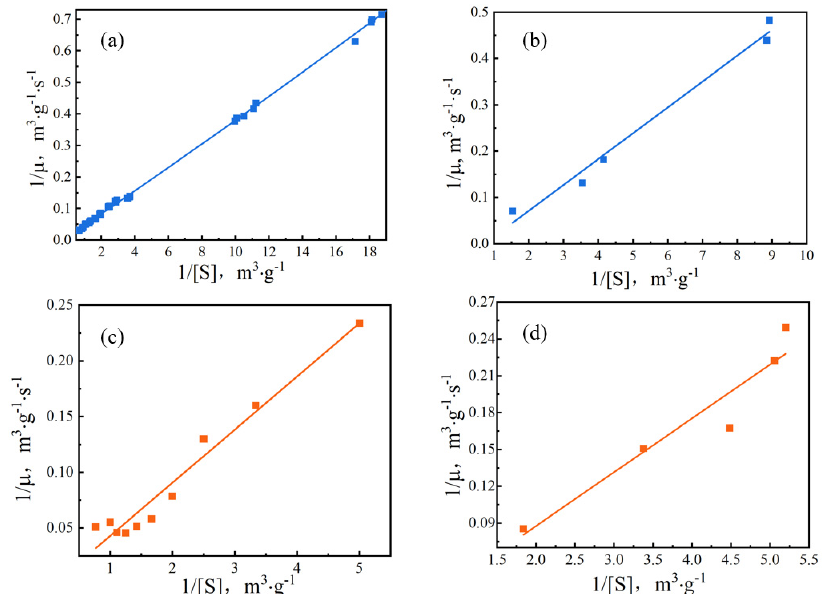
Figure 7. Kinetics of the biodegradation process. ( a ) Biodegradation of chlorobenzene; ( b ) biodegradation of chlorobenzene with mixed components substrate of chlorobenzene and xylene; ( c ) biodegradation of xylene; ( d ) biodegradation of xylene with mixed-component substrate of chlorobenzene and xylene.